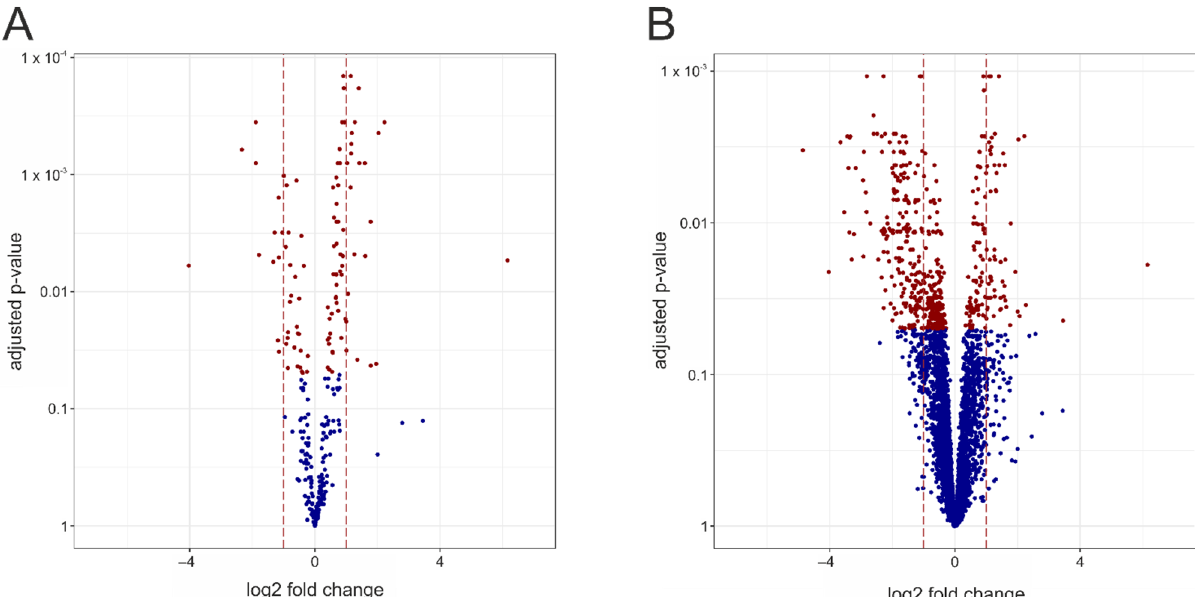
Figure 2. Volcano plots representing deregulated measurements between the Mecp2 − /y and WT cortex. Each dot represents one known metabolite. The x-axis represents the log2 fold changes between Mecp2 − /y and WT, and the y-axis the -log10 transformed adjusted p -values (as computed by a moderated t -test). Red dots correspond to those measurements with an adjusted p -value of less than 0.05, whereas blue dots indicate measurements that are not significantly deregulated. The brown vertical lines indicate the ±1 log2 fold change, corresponding to metabolites being present at double (+1) or half the level ( − 1) in the Mecp2 − /y cortex. Volcano plots are shown for the identified metabolites ( A ) and for all measurements ( B ).